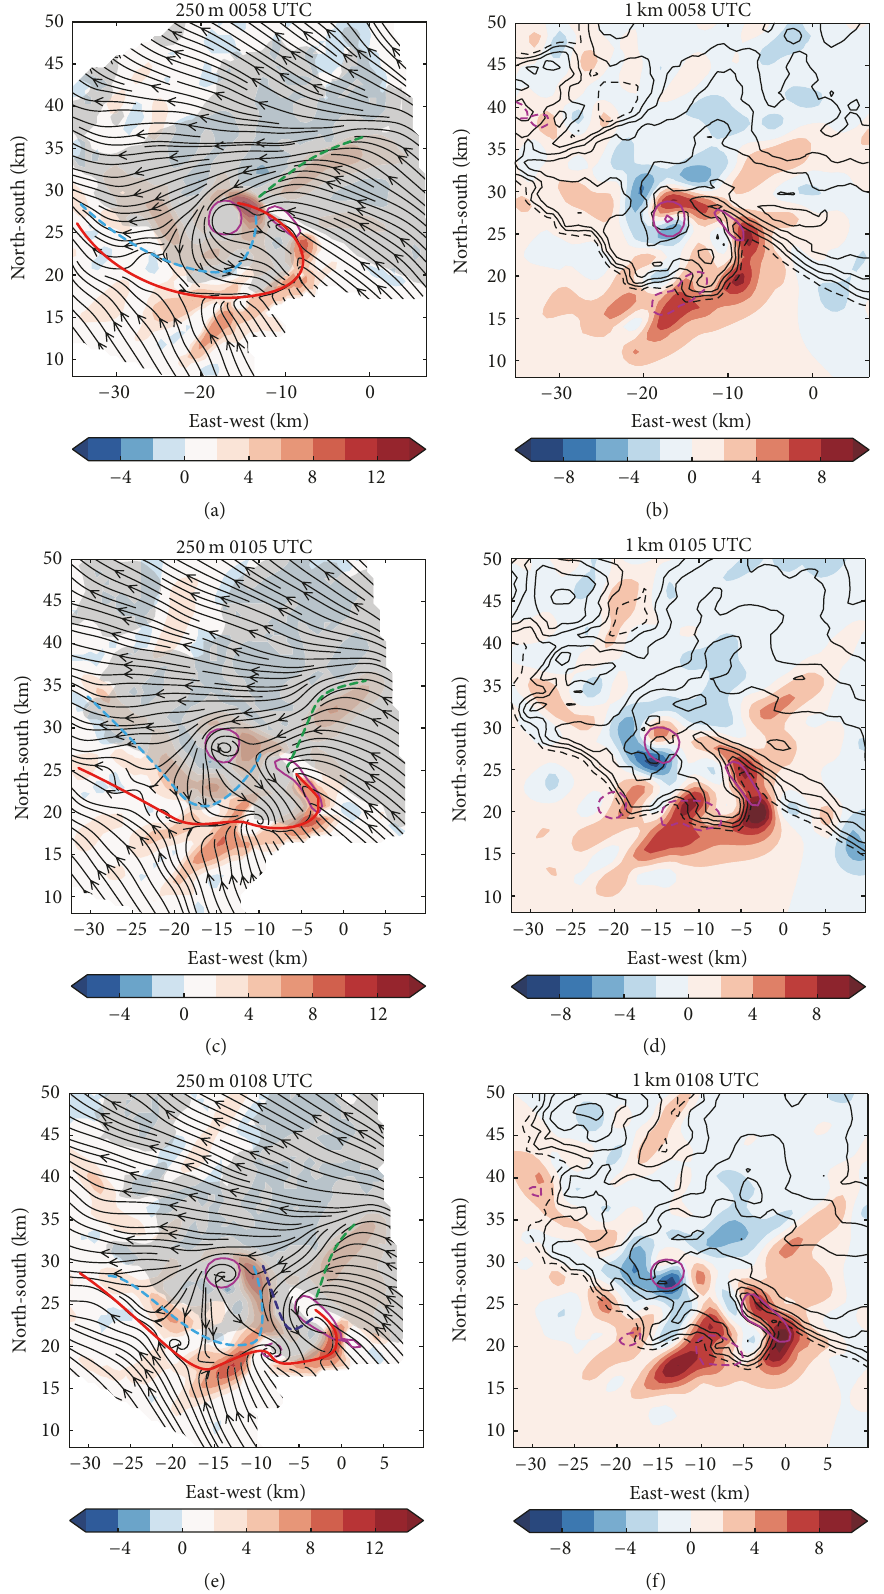
Figure 9: Same as Figure 3, except for during the development stage of the third